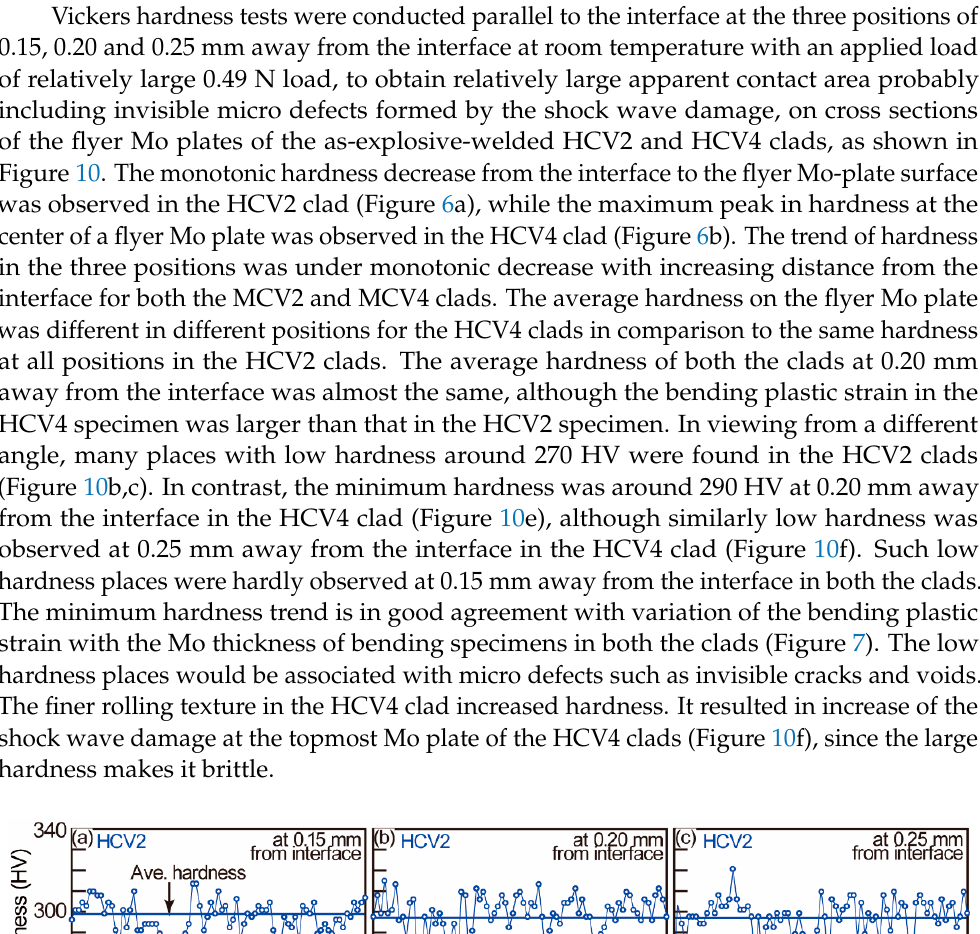
Figure 9. Cross-sectional SIM images near the Mo-plate surface of the as-explosive-welded ( a ) LCV, ( b ) HCV2 and ( c ) HCV4 clads.